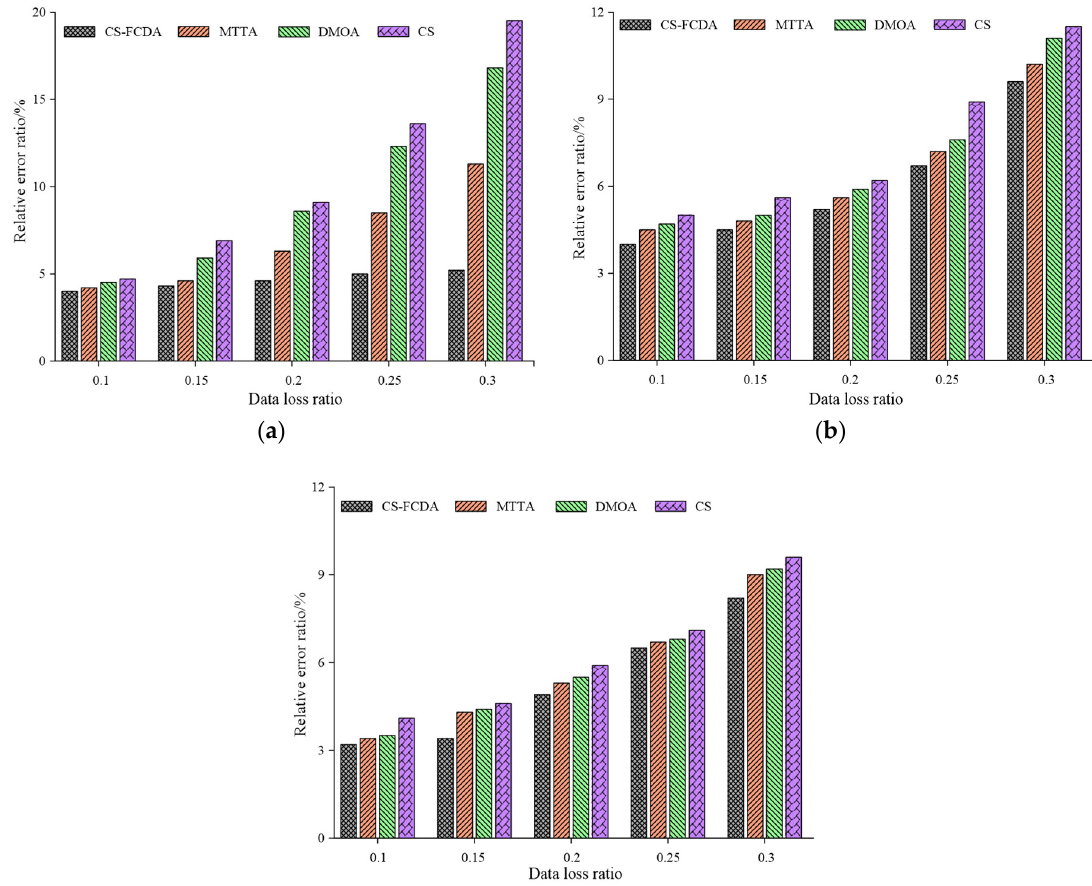
Figure 5. Comparison on relative error ratio with data loss ratio. ( a ) Comparison on relative error ratio with data loss ratio ( N = 100). ( b ) Comparison on relative error ratio with data loss ratio ( N = 300). ( c ) Comparison on relative error ratio with data loss ratio ( N = 500).